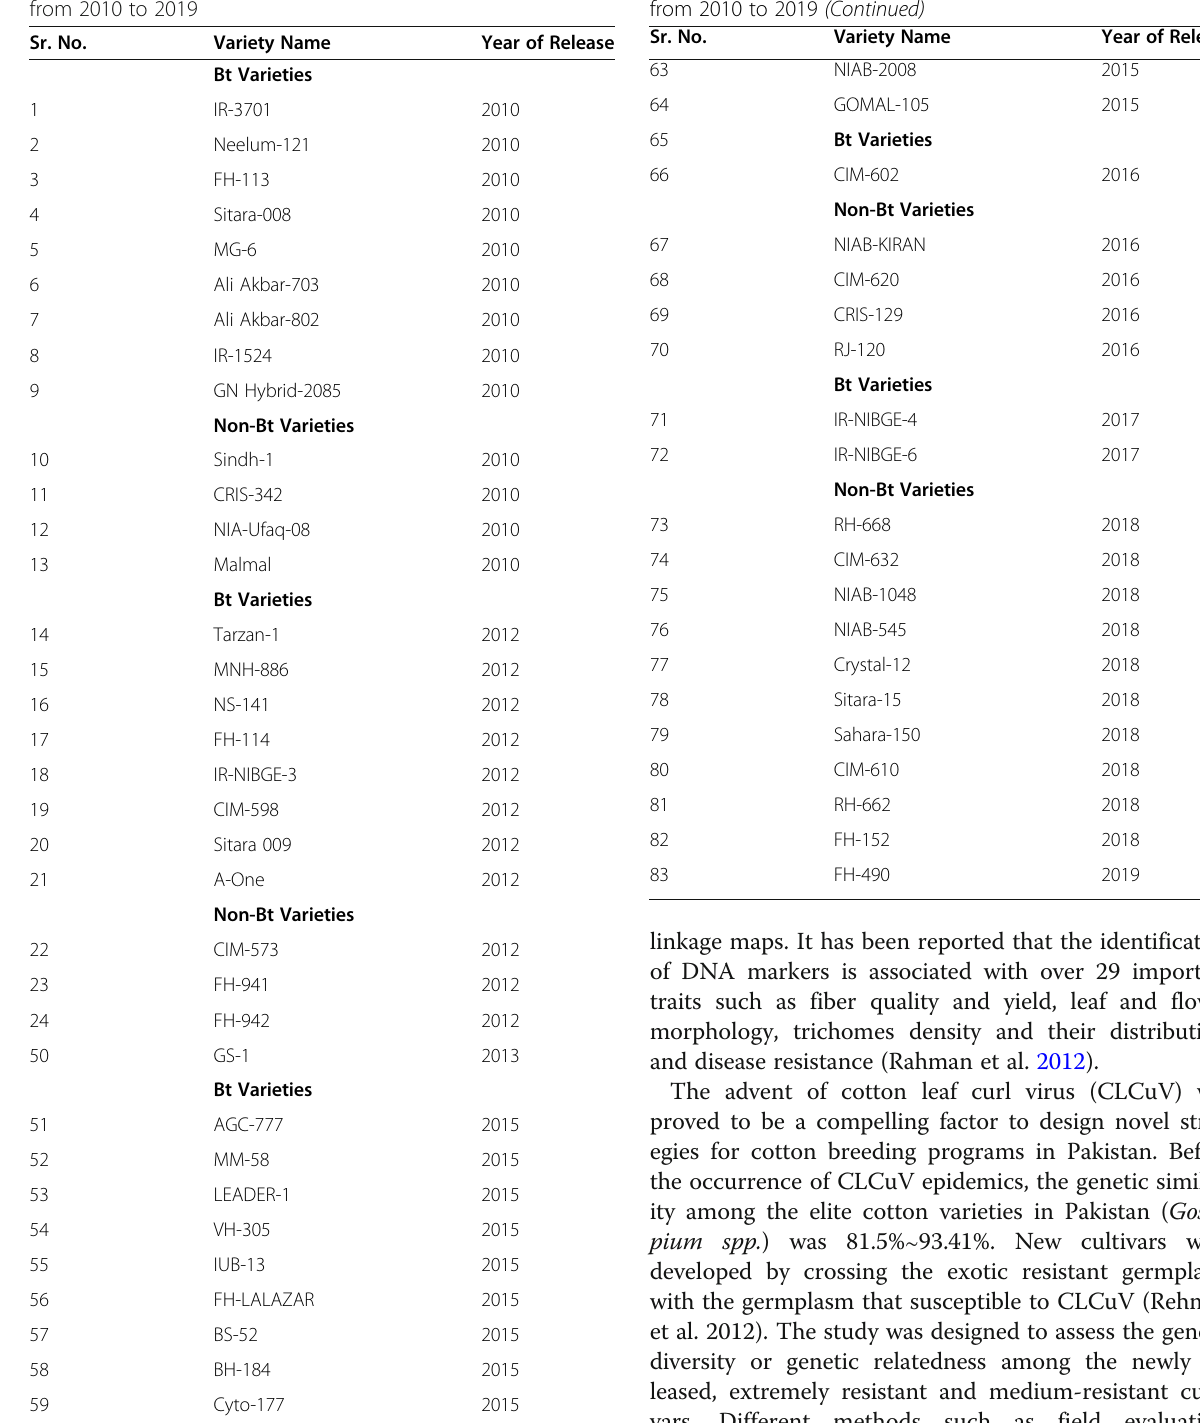
Table 2 Approved Bt and non-Bt cotton varieties in